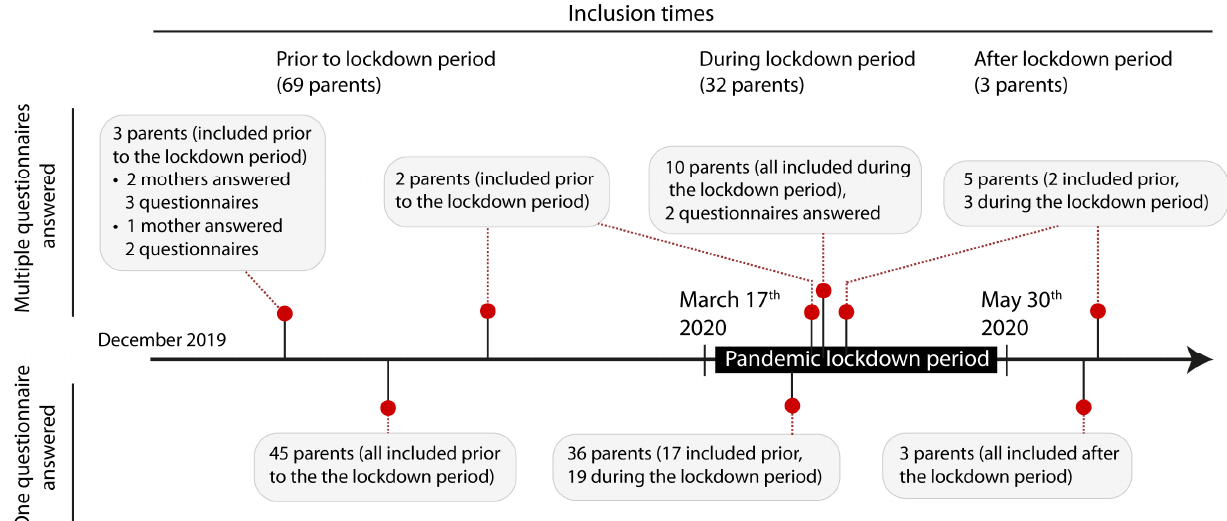
Figure 2. The lockdown period interfered unexpectedly with the study evaluation of parental self-efficacy, that is why the questionnaires filled in during the lockdown period were statistically matched with questionnaires of parents with children of the same gestational age and the same time after delivery.